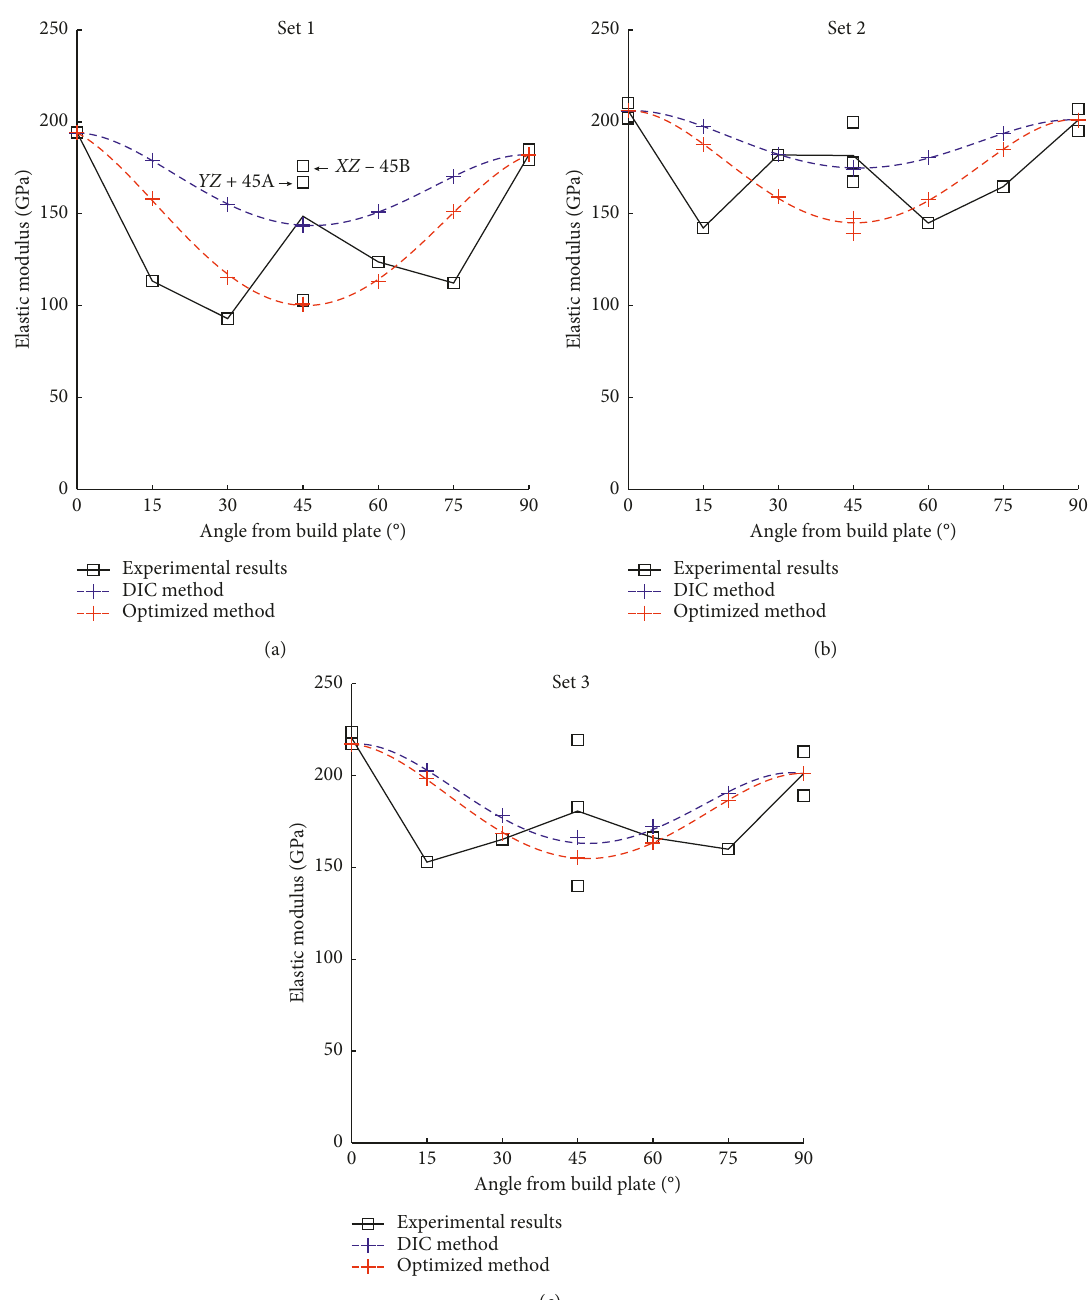
Figure 18: Elastic modulus in the load direction as measured directly, calculated based on the DIC measurements, and calculated based on the optimized elastic model for (a) as built condition, (b) aged condition, and (c) HIP + aged